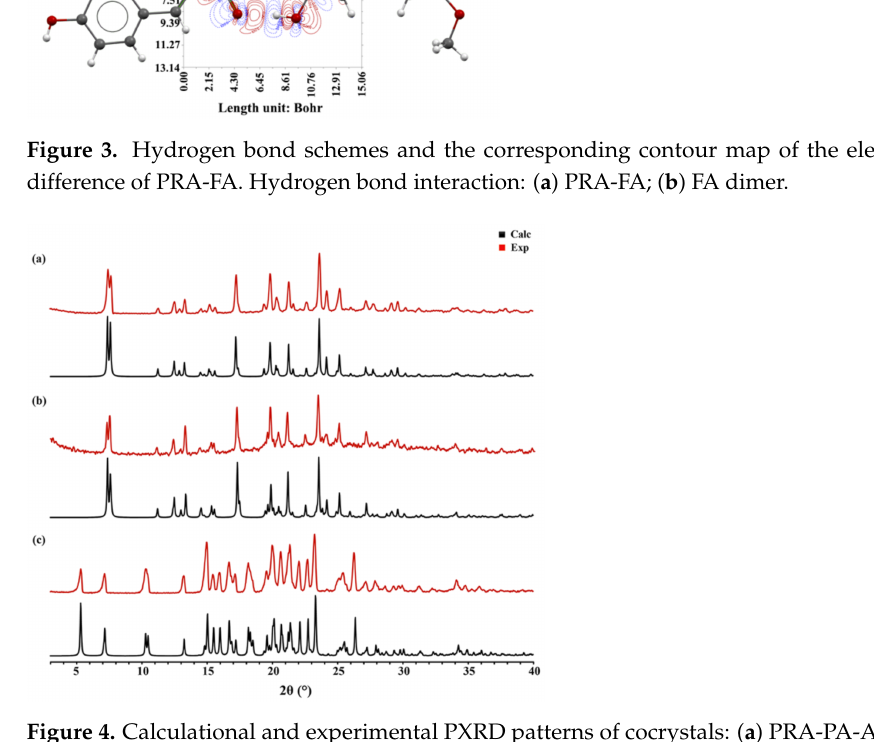
Figure 4. Calculational and experimental PXRD patterns of cocrystals: ( a ) PRA-PA-ACN; ( b ) PRA- GA-ACN; ( c )